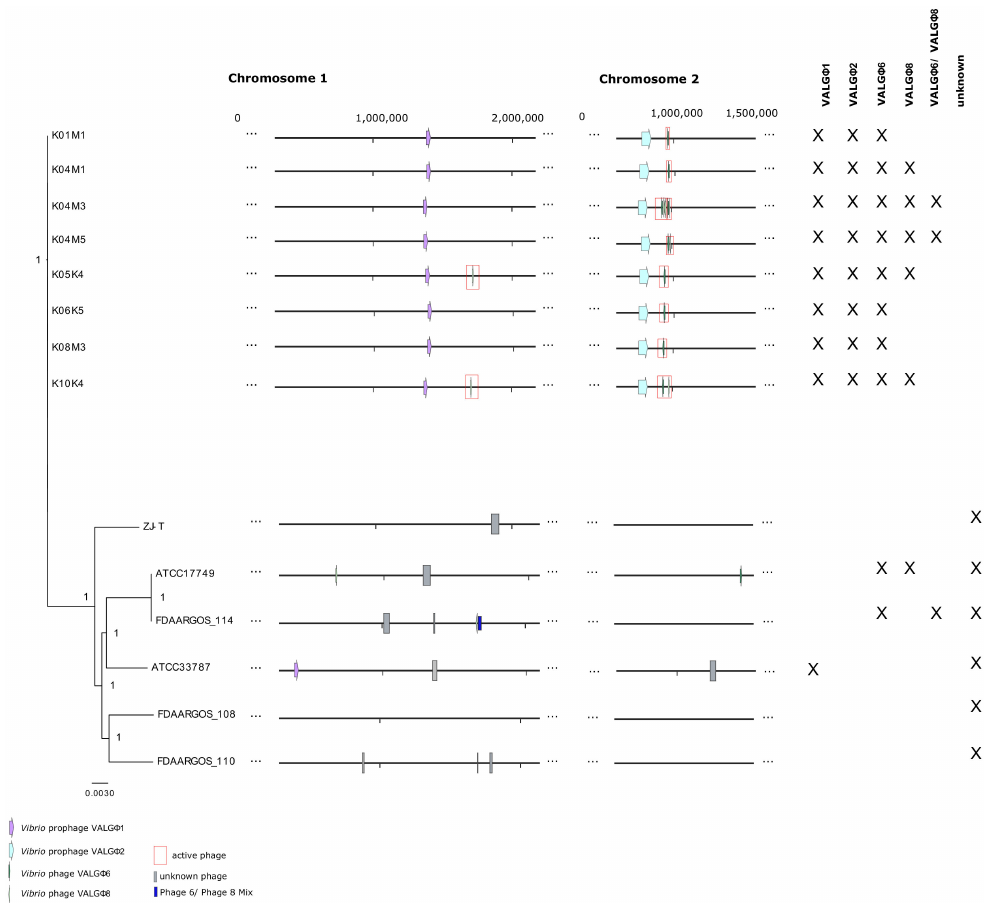
Figure 1. Left: Bayesian phylogenetic tree of all eight Kiel V. alginolyticus isolates (top) and six other fully sequenced V. alginolyticus isolates based on a core-genome alignment. Node-values represent bootstrap values; for additional information on the tree please see [26]. More information, regarding isolation source can be found in Tables S1 and S3. Middle: Whole chromosome alignment with prophage regions in colored boxes / arrows. Actively replicating prophages are marked in red. Blocks of the same color indicate prophage-types: purple, Vibrio prophage VALG Φ 1; light blue, Vibrio prophage VALG Φ 2; dark green, Vibrio phage VALG Φ 6; light green, Vibrio phage VALG Φ 8; dark blue, adjacent sequences of Vibrio phage VALG Φ 6 and Vibrio phage VALG Φ 8; grey, unknown phages. Right: presence (x) of selected vibriophages in each